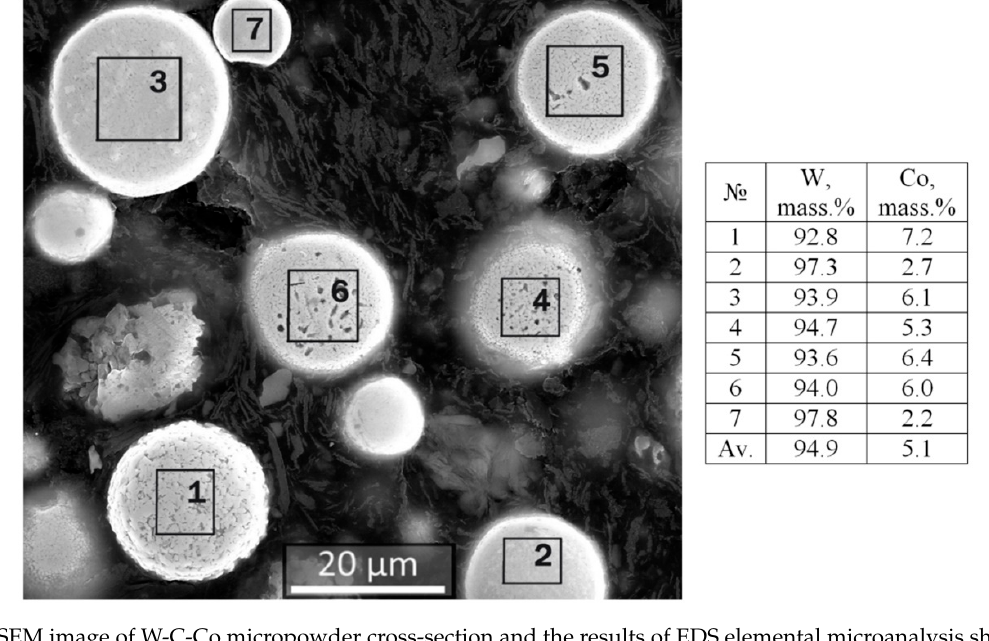
croanalysis showing the Co and W content in the powder particles with different structures. Co and W content in the powder particles with different structures.